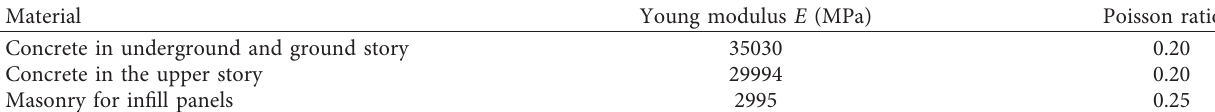
Table 4: Elastic properties of the materials assumed in the FE models.